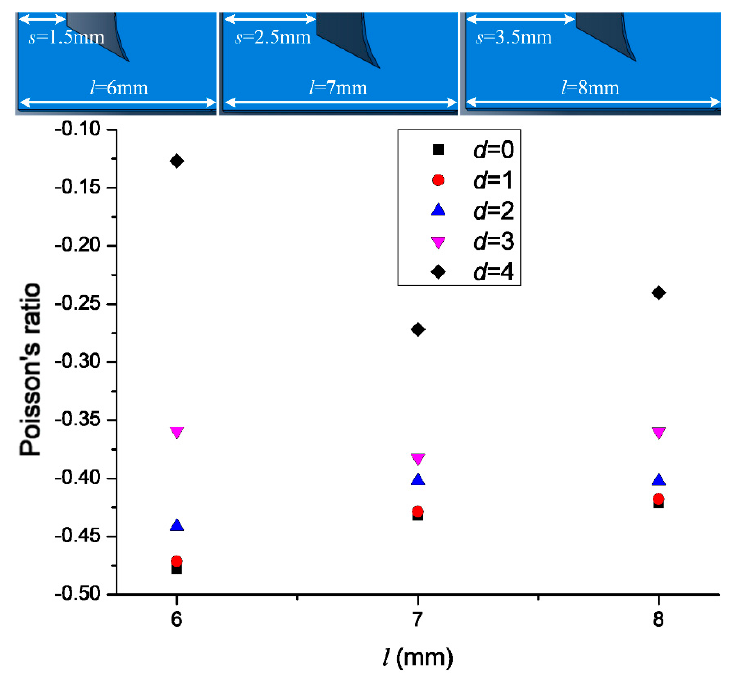
Figure 7. Relationship between l and Poisson’s ratio.